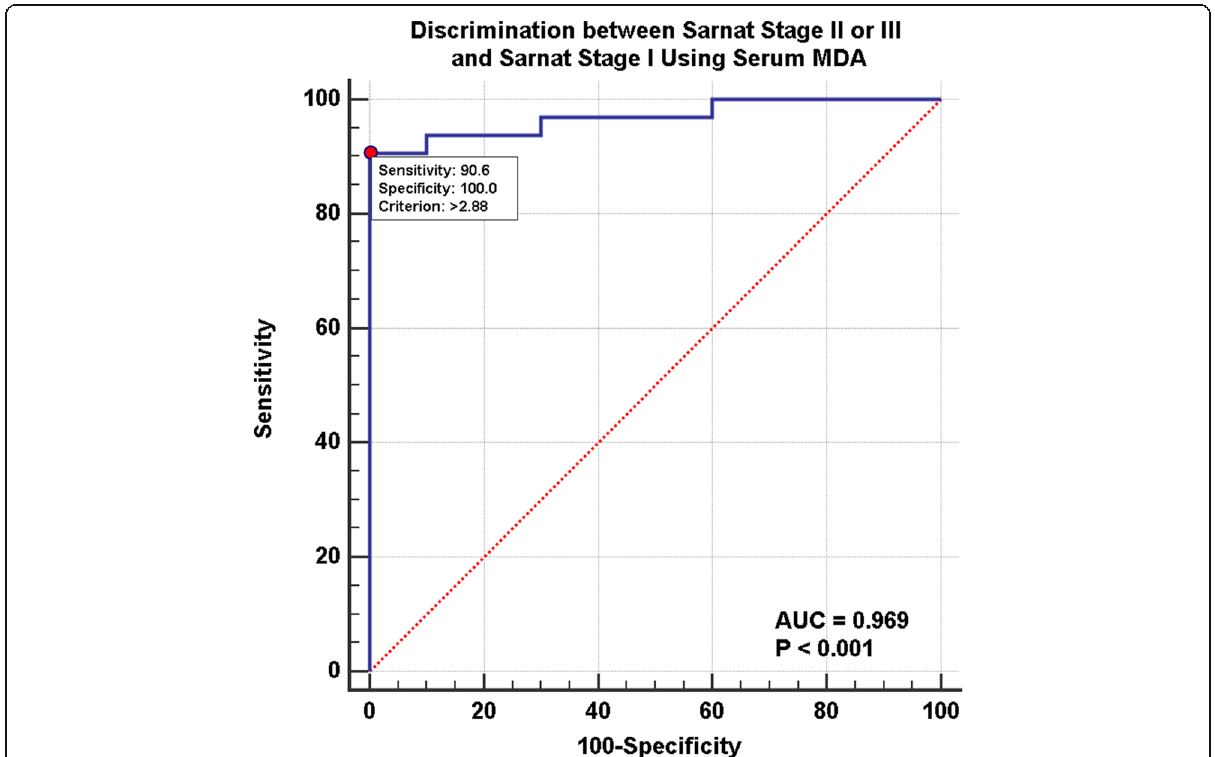
Fig. 4 ROC curve analysis for discrimination between Sarnat stage II or III and Sarnat stage I patients using serum MDA levels. Cut-off MDA level is > 2.88 nmol/ml and area under the curve is 0.969. Sensitivity of MDA in Sarnat II or III compared to stage I was 90.62% and sensitivity was